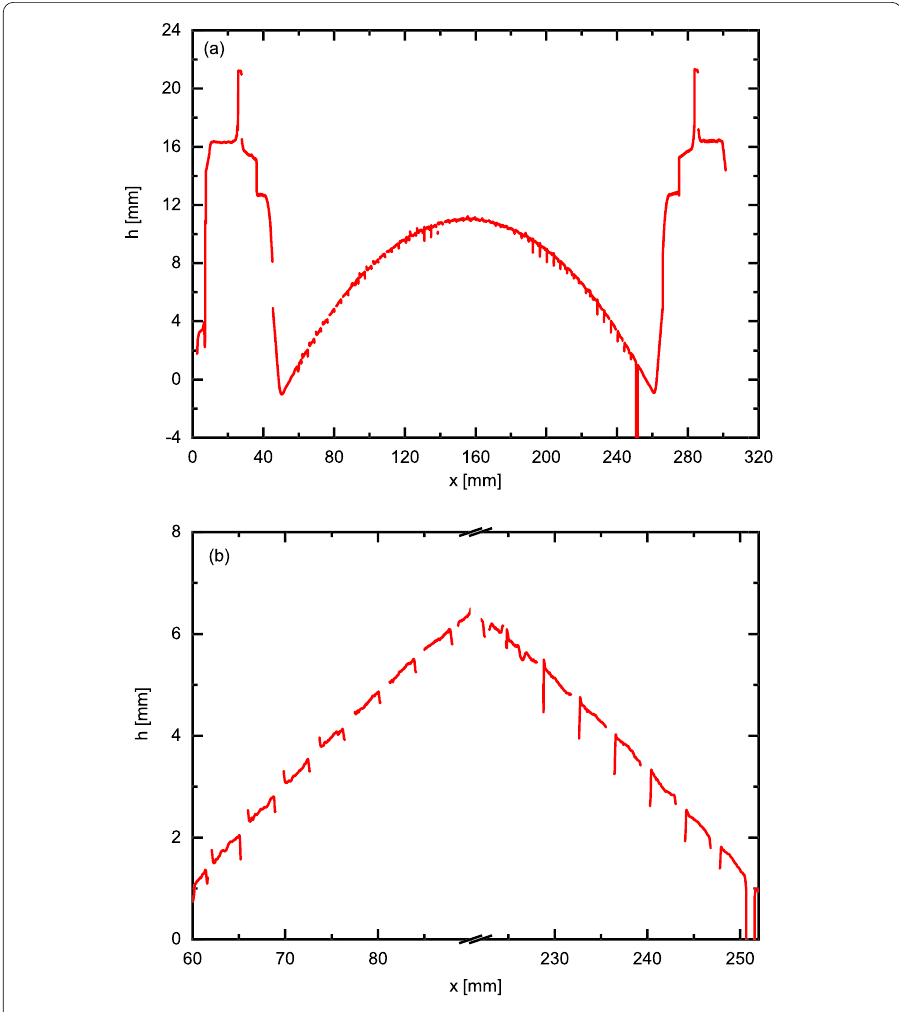
Figure 11 TLH scan across the diameter of the RIT-22: full scan ( a ) and enlarged details ( b )